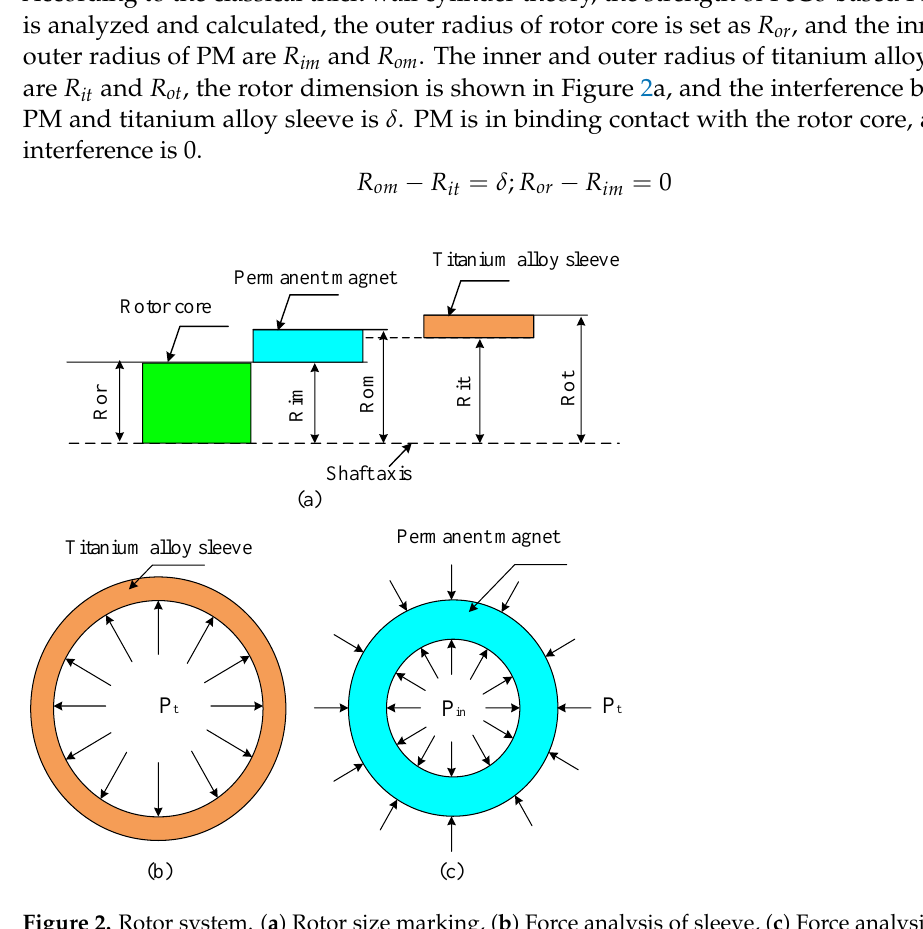
Figure 2. Rotor system. ( a ) Rotor size marking, ( b ) Force analysis of sleeve, ( c ) Force analysis of PM.